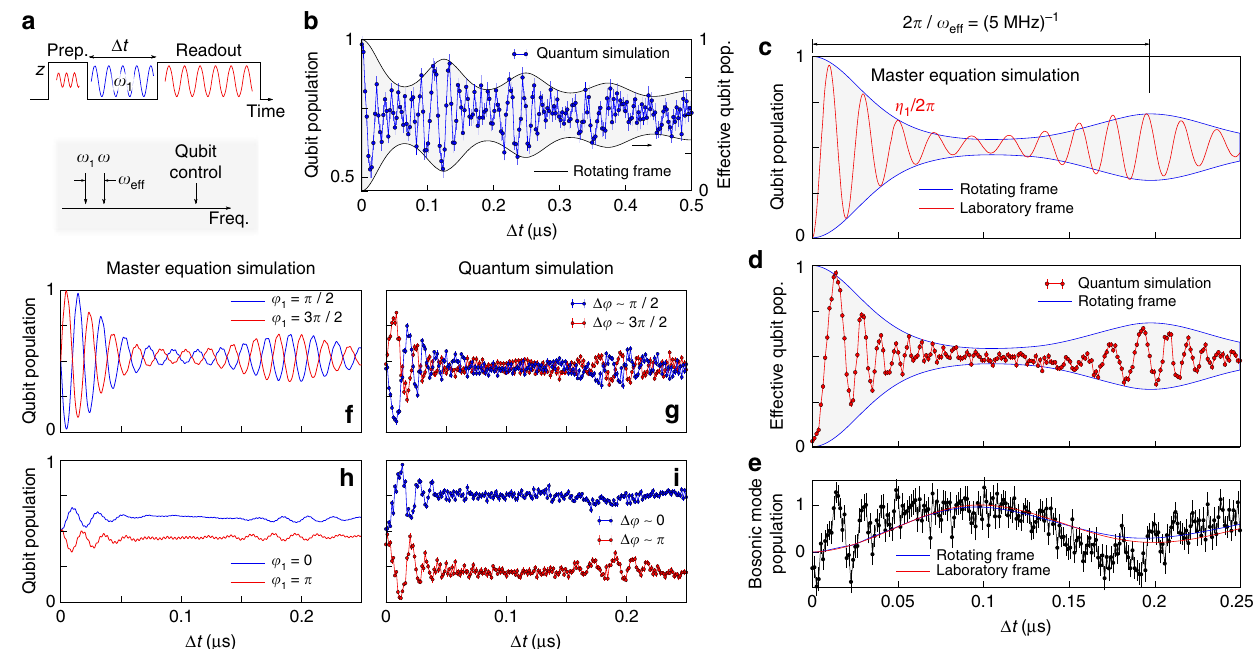
Fig. 3 Quantum state collapse and revival with only the dominant Rabi drive applied. a Schematic pulse sequence and overview on the relative frequencies used in the experiment. b Quantum simulation of the periodic recurrence of quantum state revivals for ω eff /2 π = 8 MHz. The blue line corresponds to a master equation simulation of the qubit evolution in the rotating frame. c , d Master equation and quantum simulation of the qubit time evolution for initial qubit states g j i , e j i and ω eff /2 π = 5 MHz, corresponding to g eff = ω eff (cid:5) 0 : 5. The red line shows the qubit population evolution of the driven system in the laboratory frame, Eq. (2), while the blue lines follow the qubit evolution in the synthesized Hamiltonian Eq. (4), likewise extracted from a classical master equation simulation. The deviation between the envelope of the laboratory frame data and the rotating frame data in c re fl ects the approximations of the simulation scheme. Experimental data shows the difference between two measurements for the qubit prepared in g j i , e j i , respectively, in order to isolate the qubit signal. e Measured population evolution of the bosonic mode, extracted from the sum of the two successive measurements and fi tted to classically simulated data. f – i Qubit time evolution for varying relative phase φ 1 of the applied drive. The initial qubit state is prepared on the equator of the Bloch sphere g j i ± e j i . Dispersive shifts induced by the bosonic mode are subtracted based on its classically simulated population evolution. Error